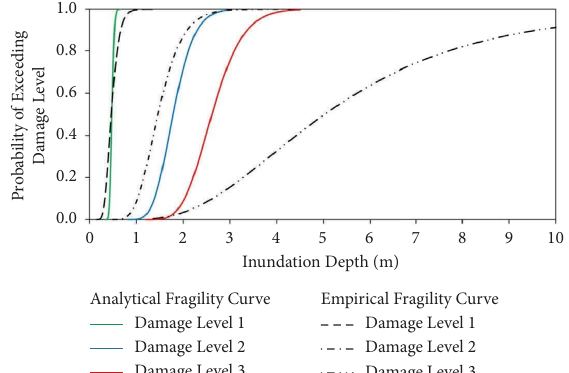
Figure 14: A comparison of the analytical fragility curve with the empirical fragility curve proposed by Foytong and Ruangrassamee [11].